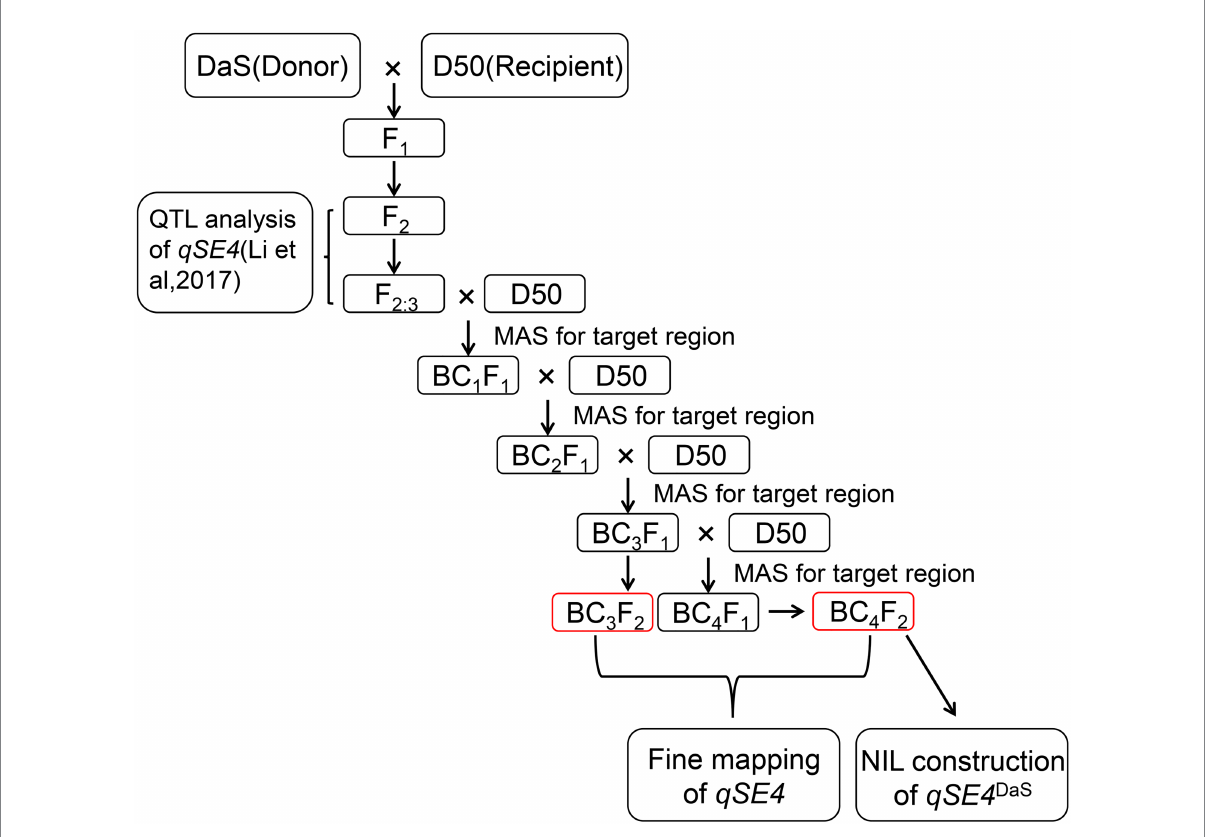
FIGURE 1 Roadmap of constructing near-isogenic lines and fine mapping